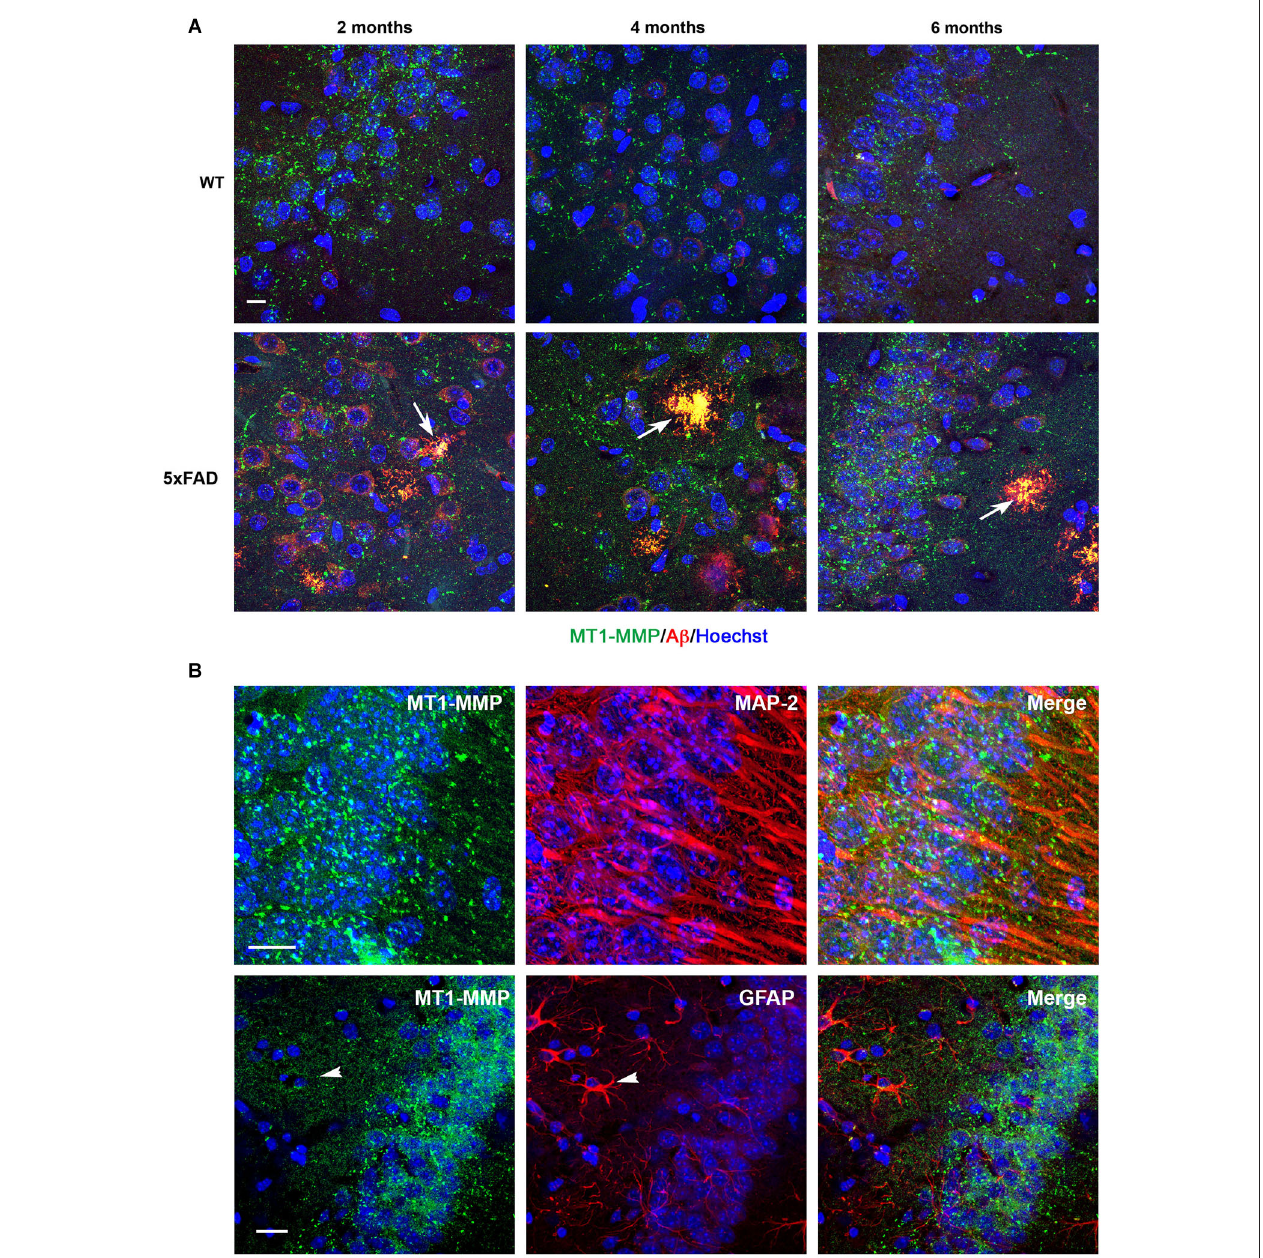
in the neuronal cell layer. MT1-MMP immunostaining increases at 6 months in 5xFAD hippocampi and colocalizes with amyloid plaques at all ages studied, as revealed by yellow color (arrows). Hoechst (blue) labels cell nuclei. (B) High power magnifications of 5xFAD subiculum showing localization of MT1-MMP (green) to MAP-2+ neuronal cell bodies (red, upper panels), and no colocalization with GFAP+ astrocytes (red, lower panels). Scale bars: 10 µ m.